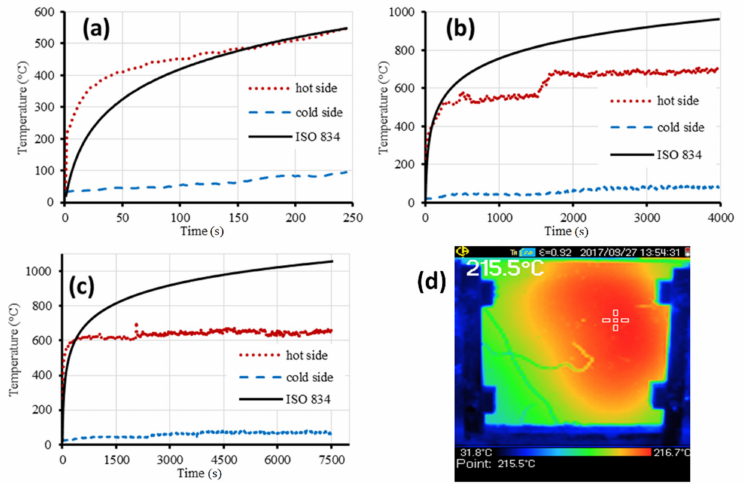
Figure 7. Temperature–time curves of fire resistance tests for different coating layer thicknesses: ( a ) uncoated, ( b ) 10 mm, ( c ) 20 mm and ( d ) the cold-side temperature. Micrographs and photographs of the surface of the GF are shown in Figure